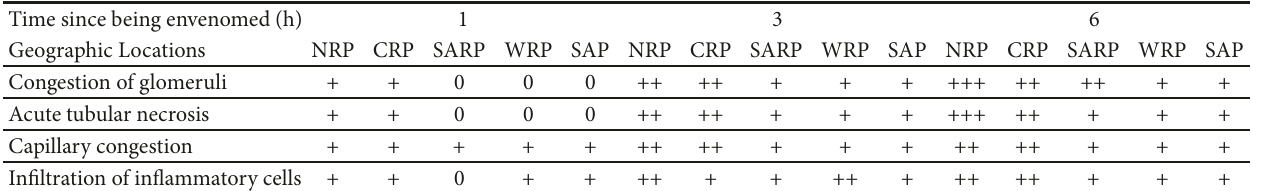
Table 4: Major histopathological changes in Kidney by N. naja venom from distinct geographic origins in Sri Lanka. Score: 0: absent; +: mild; ++; moderate; and +++: severe [45]. Time since being envenomed (h) 1 3 6